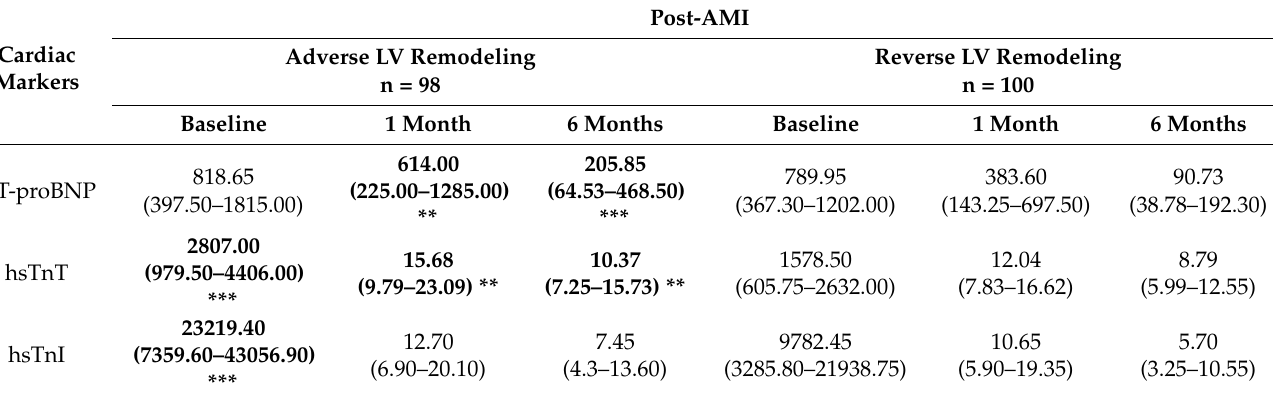
Footnotes for Table 2: Data are presented as median ± IQR. Significant differences between adverse and reverse remodeled groups at individual time-points are indicated as ** p ≤ 0.01; *** p ≤ 0.001. Abbreviation: